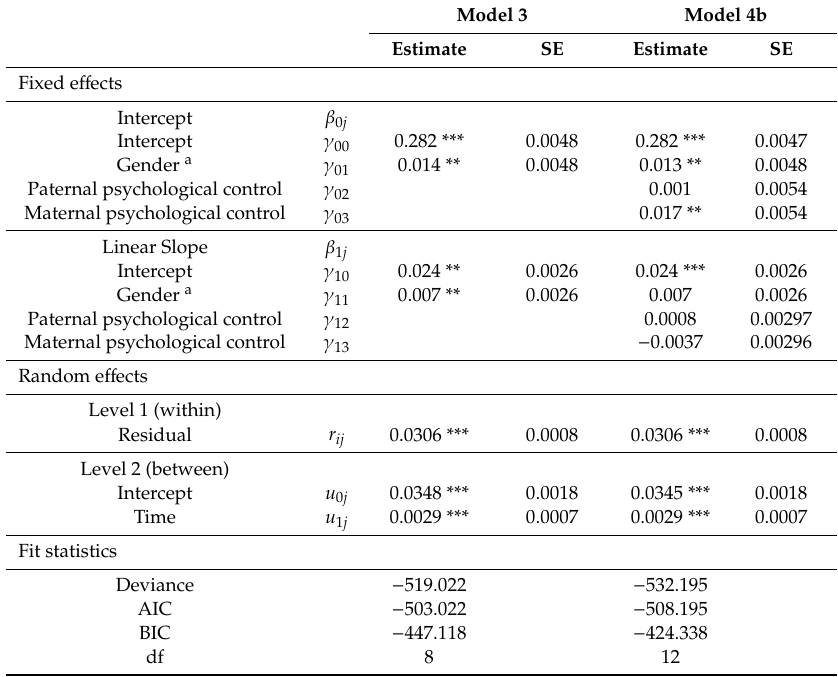
Table 6. Results of IGC models with Level-2 predictors for adolescent delinquency (Waves 1–3).